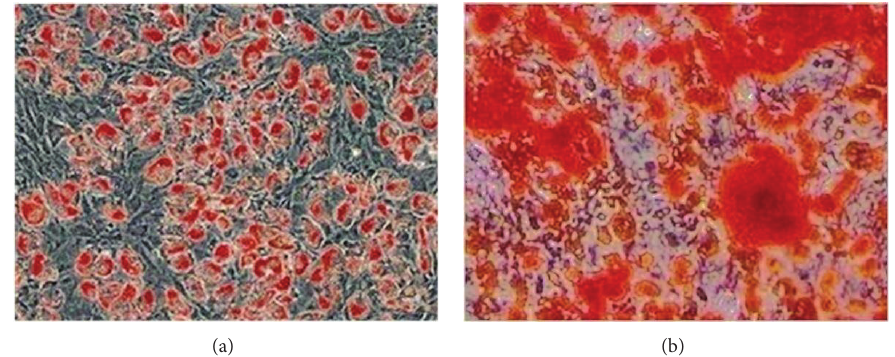
Figure 2: Adipogenic and osteogenic differentiation potential of bone marrow-derived stem cells (BMSCs). Oil Red O staining (a) and Alizarin Red staining (b) were both positive, indicating the adipogenic and osteogenic differentiation potential of BMSCs. Magnification: × 100 (a-b).